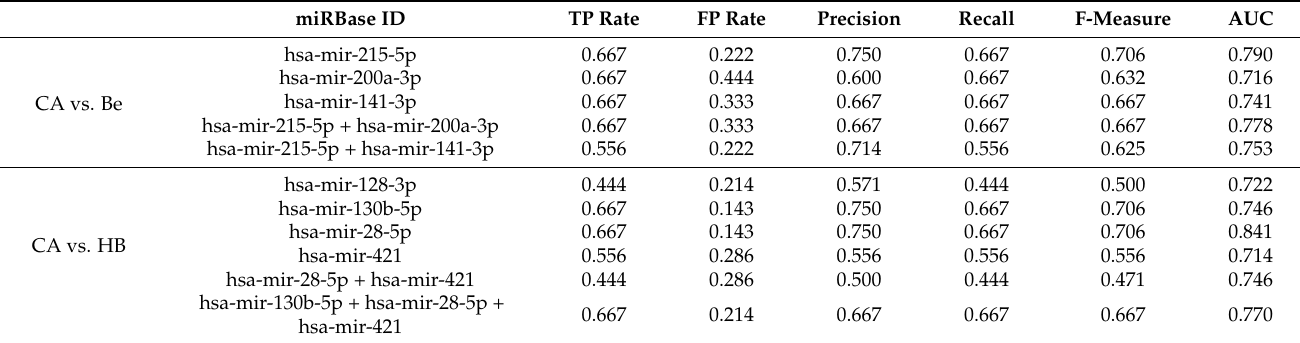
Table 3. Potential miRNA biomarkers to detect cancer in no- and high-risk benign breast tumors.